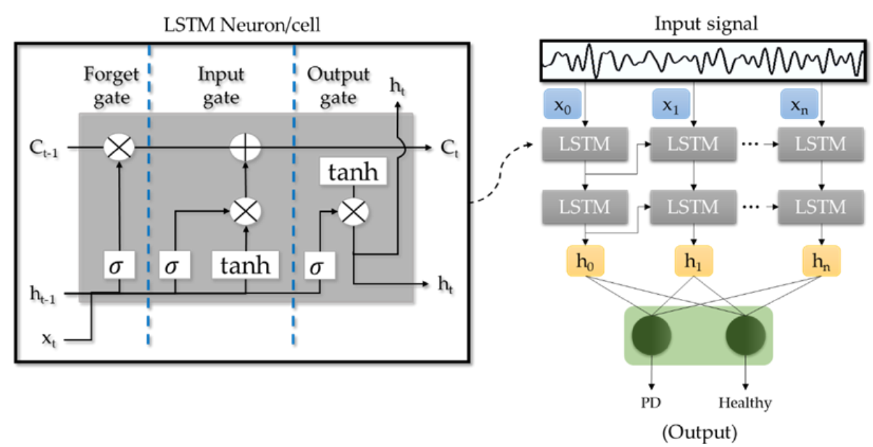
Figure 3. Basic architecture of the LSTM model.